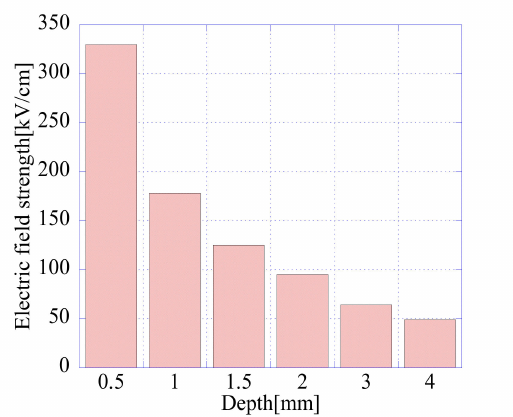
Figure 19. Electric field strength of the center of the bottom in the hollow calculated by the simulation for each depth of hollow in configuration